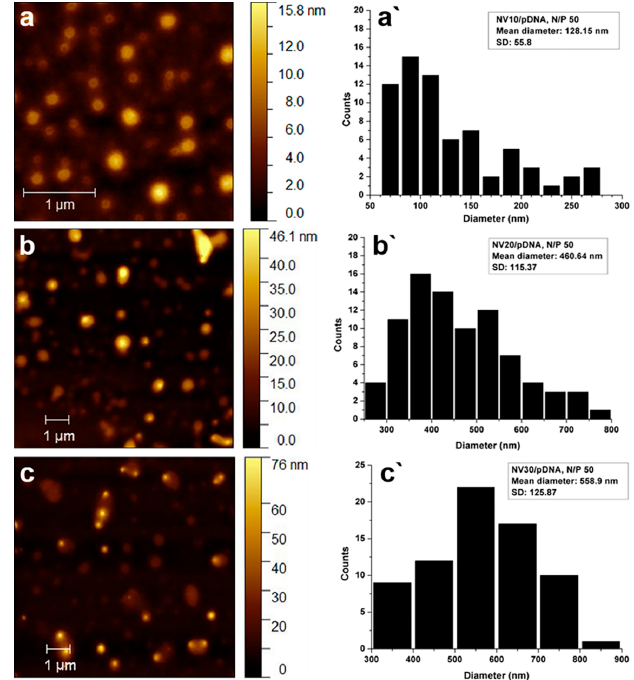
Figure 5. AFM imaging for ( a ) NV10/pDNA polyplex, ( b ) NV20/pDNA polyplex and ( c ) NV30/pDNA polyplex. Size distribution for ( a` ) NV10/pDNA polyplex, ( b` ) NV20/pDNA polyplex and ( c` ) NV30/pDNA polyplex at N/P ratio of 50; 80 particles were measured to obtain diameter distribution path.